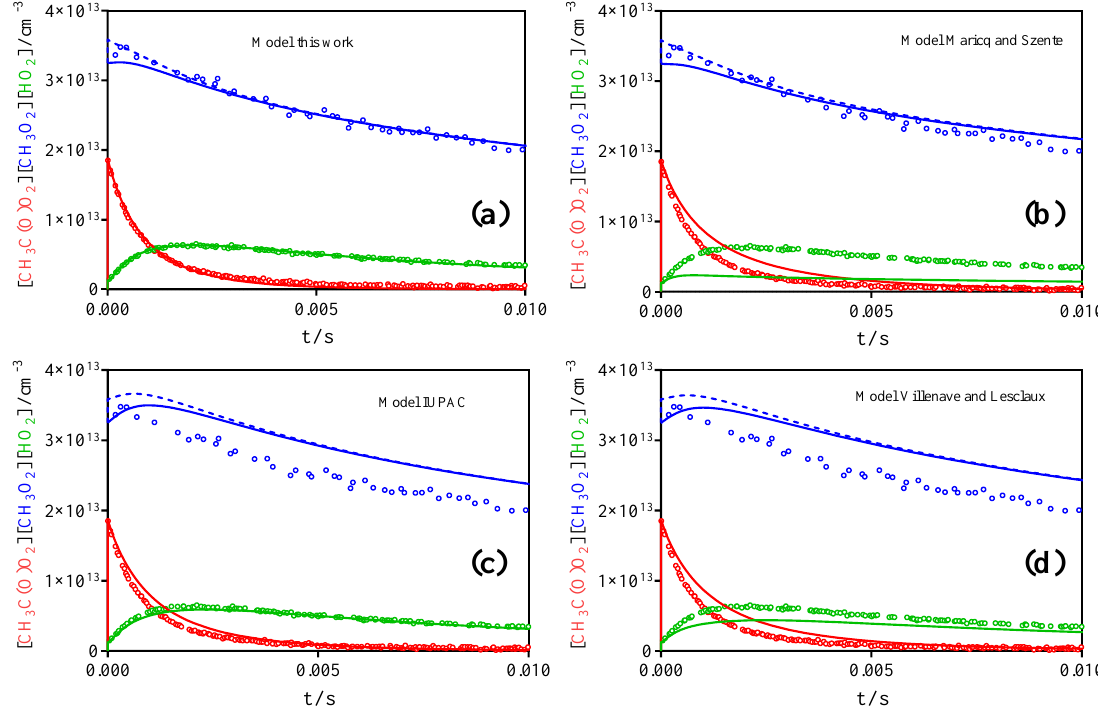
Figure 8. Highest radical concentration from 248 nm photolysis of CH 3 C(O)CH 3 shown in Figure 6 (red symbols from the left column): CH 3 O 2 • profile in blue, HO 2 • profile in green and CH 3 C(O)O 2 • profile in red. ( a ) model as given in Table 3, ( b ) same model, but rate constants for (R1) and (R2) such as propose by Maricq and Szente [17], ( c ) same model, but k 1 and k 2 such as recommended currently by IUPAC [30], ( d ) same, but k 1 and k 2 from Villenave and Lesclaux [28] (see Table 1).